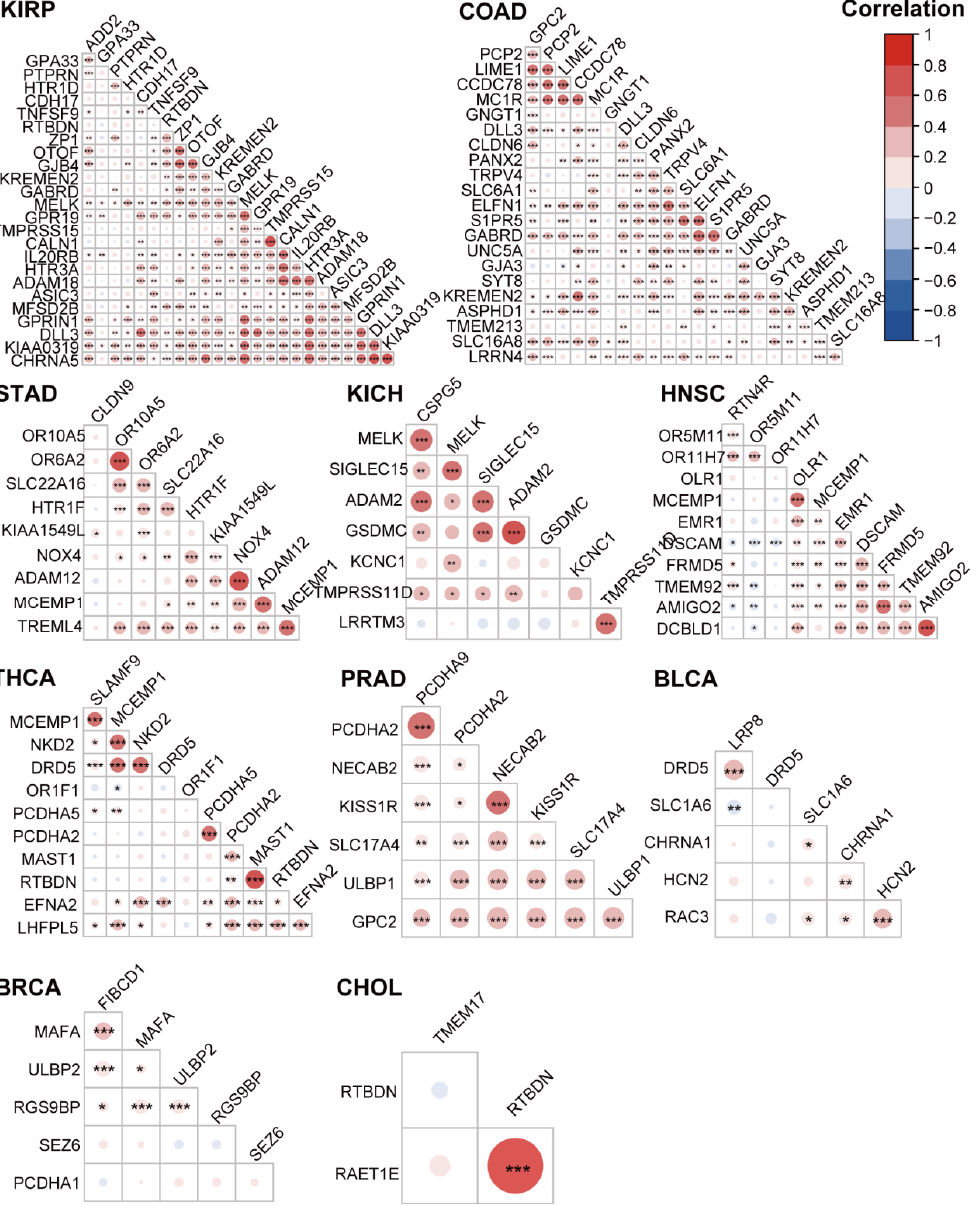
Figure 5. Correlation analysis of the membrane protein-coding genes in different tumor types. The bubble plot shows the Pearson correlation between the high-expression and high-risk membrane protein-coding genes for various cancers from Table 2. The red bubbles represent positive correlations. The blue bubbles represent negative correlations. * means p < 0.05, ** means p < 0.01, and *** means p < 0.001.